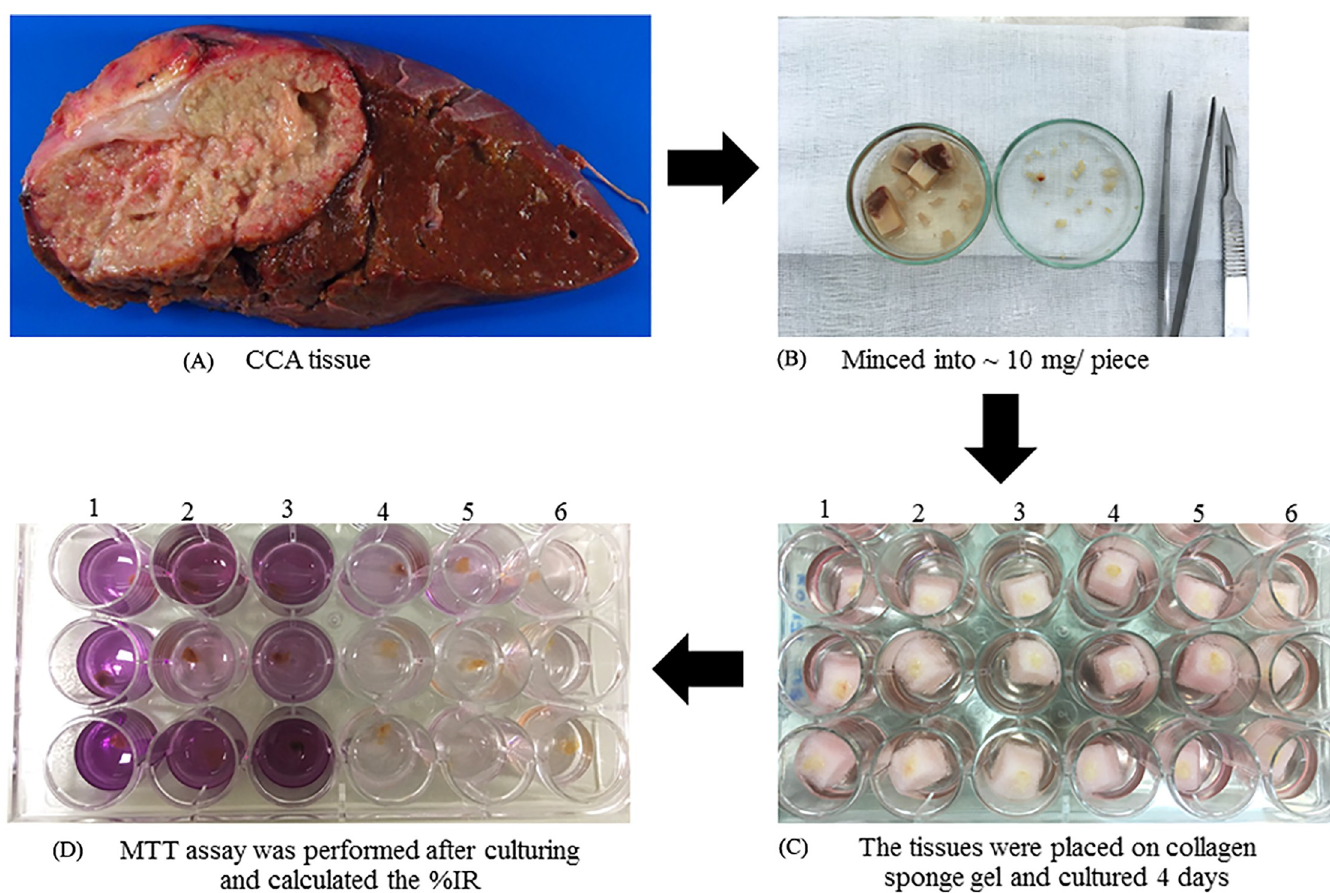
Fig 1. The protocol of HDRA method. (A) The fresh tumor tissue of CCA patients after surgery. (B) The tumor tissues were minced into small pieces and weight ~10 mg/piece. (C) The small piece of tumor tissues was placed on sponge gel and culture for 4 days in conditioned media without and with designing drug concentrations, respectively (D) After culturing, the tissues were performed MTT assay and calculated %IR in each condition. Conditions including 1 = control, 2 = 1000 μ g/ml gemcitabine, 3 = 1500 μ g/ml gemcitabine, 4 = 20 μ g/ml cisplatin, 5 = 25 μ g/ml cisplatin and 6 = 1000 μ g/ml gemcitabine + 20 μ g/ml cisplatin.